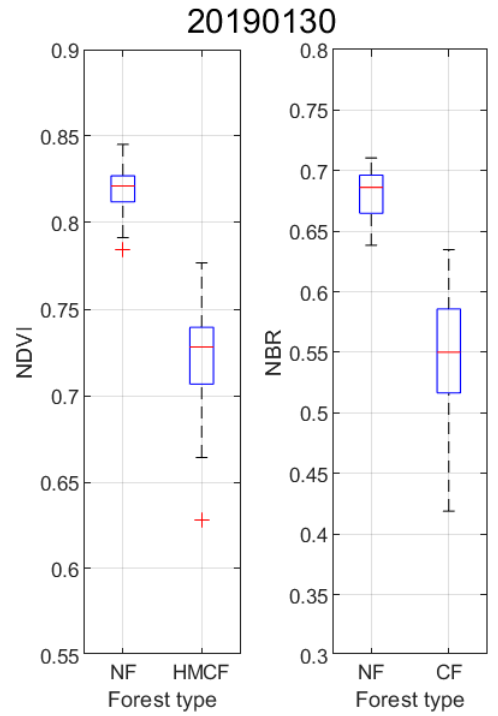
Figure 6. Normalized difference vegetation index (NDVI) and normalized burned ratio (NBR) derived from the 2019 Landsat-8 OLI imagery. The mean (SD) values of NDVI at the NF and HMCF sites are 0.818 (±0.014) and 0.721 (±0.030), respectively. The mean (SD) values of NBR at the NF and HMCF sites are 0.681 (±0.019) and 0.543 (±0.059), respectively.